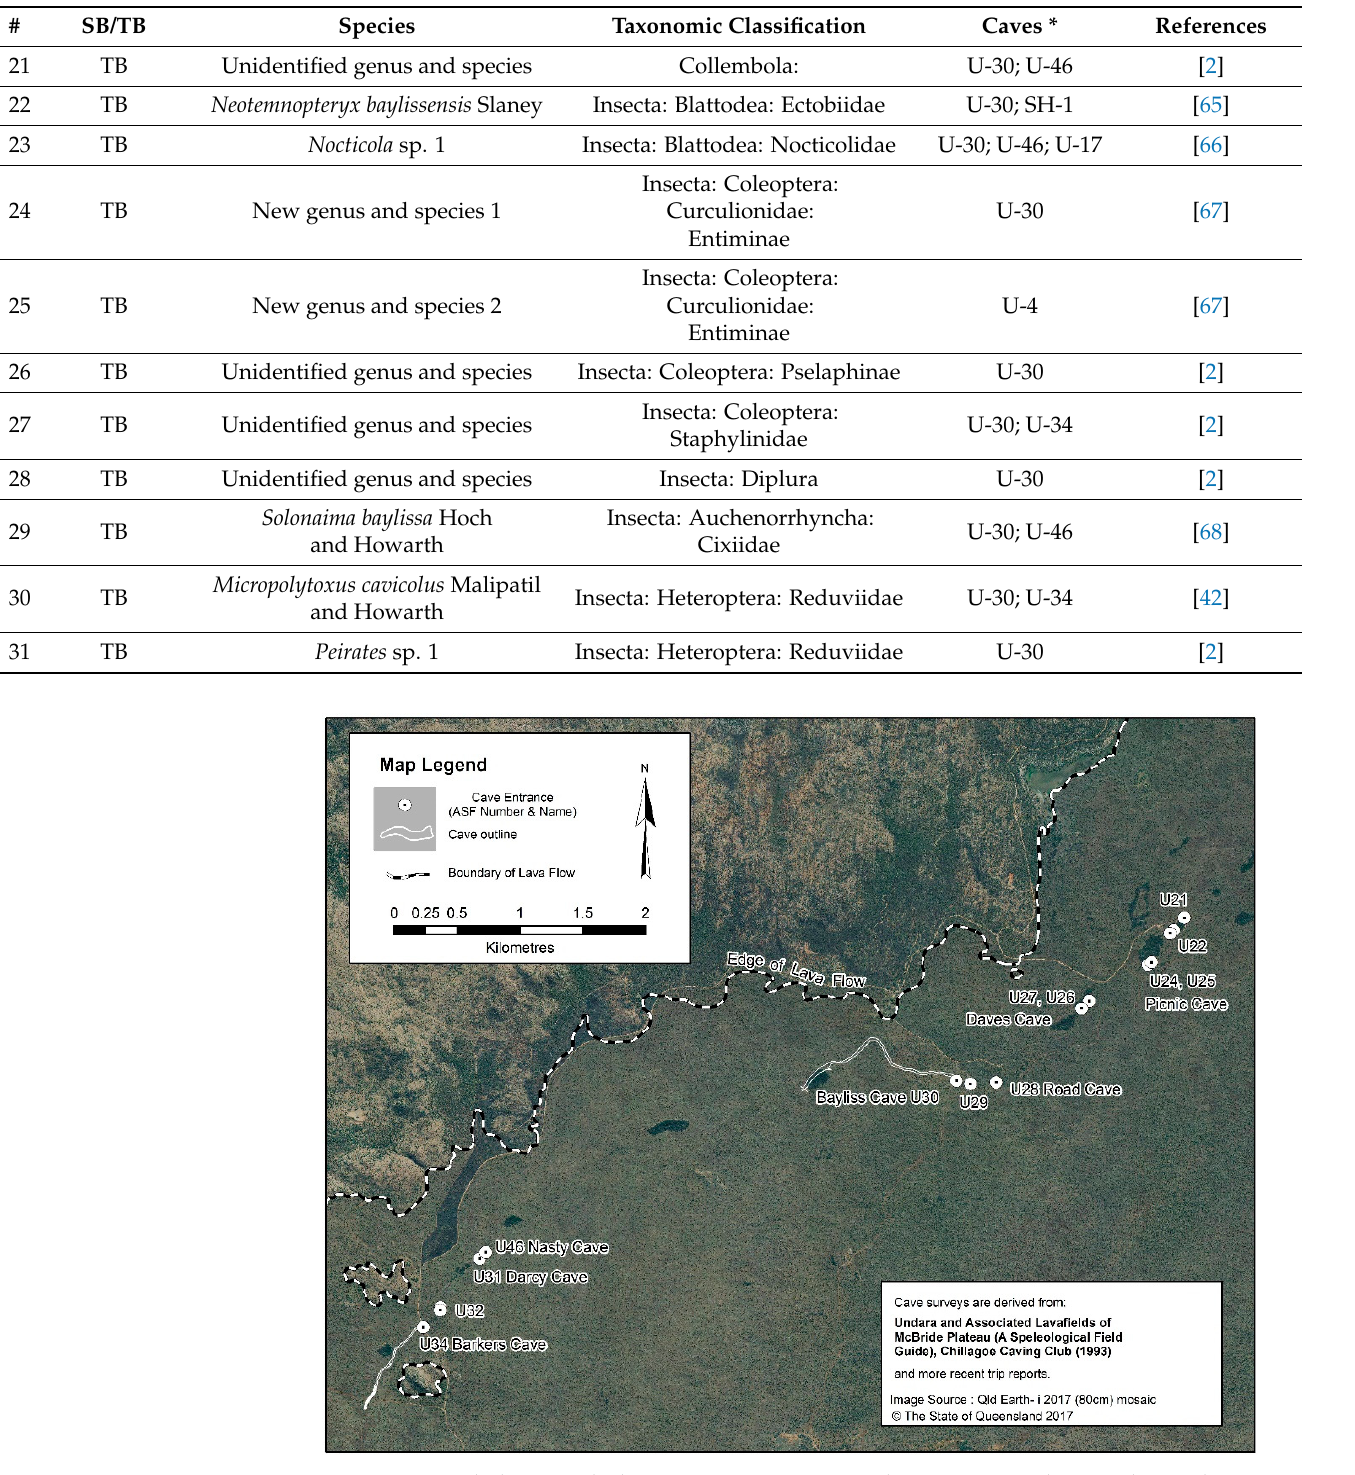
Figure 4. Aerial photograph showing cave entrances and major cave outlines in the north-western tube system at 23.5 to 31.5 km from Undara Crater. This 8 km section contains the two longest mapped tube segments in the Undara Flow, Bayliss Cave and Barkers Cave, and other biologically important segments including Nasty Cave and Road Cave (refer Table 2).